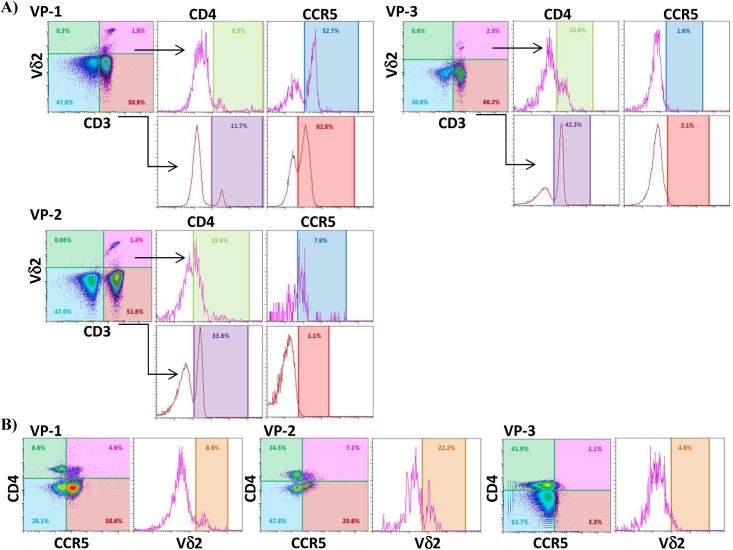
Vδ2 cells from untreated recently HIV-infected patients express CD4 and CCR5.
A) Dot plots from three recently infected patient (VP1, VP2 and VP3) showing surface expression of CD4 and CCR5 on CD3+Vδ2+ cells, and on CD3+Vδ2- cells for comparison. B) Density plots showing the percentage of Vδ2 cells coexpressing CD4 and CCR5 in the same three patients.